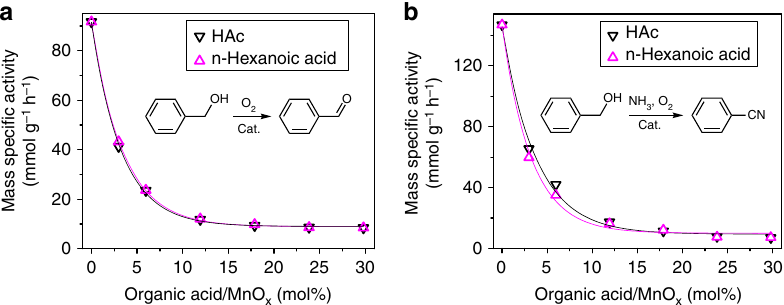
Fig. 3 Oxidative activities of unmodi fi ed and HAc-modi fi ed MnO x . a Mass-speci fi c activity (mmol g cat -1 h -1 ) of MnO x in benzyl alcohol oxidation as a function of the organic acid/MnO x ratio. b Mass-speci fi c activity (mmol g cat -1 h -1 ) of MnO x in benzyl alcohol ammoxidation as a function of the organic acid/MnO x ratio. The Mn content was analyzed by inductively coupled plasma atomic-emission spectroscopy. The mass-speci fi c activity was measured below 30% conversion